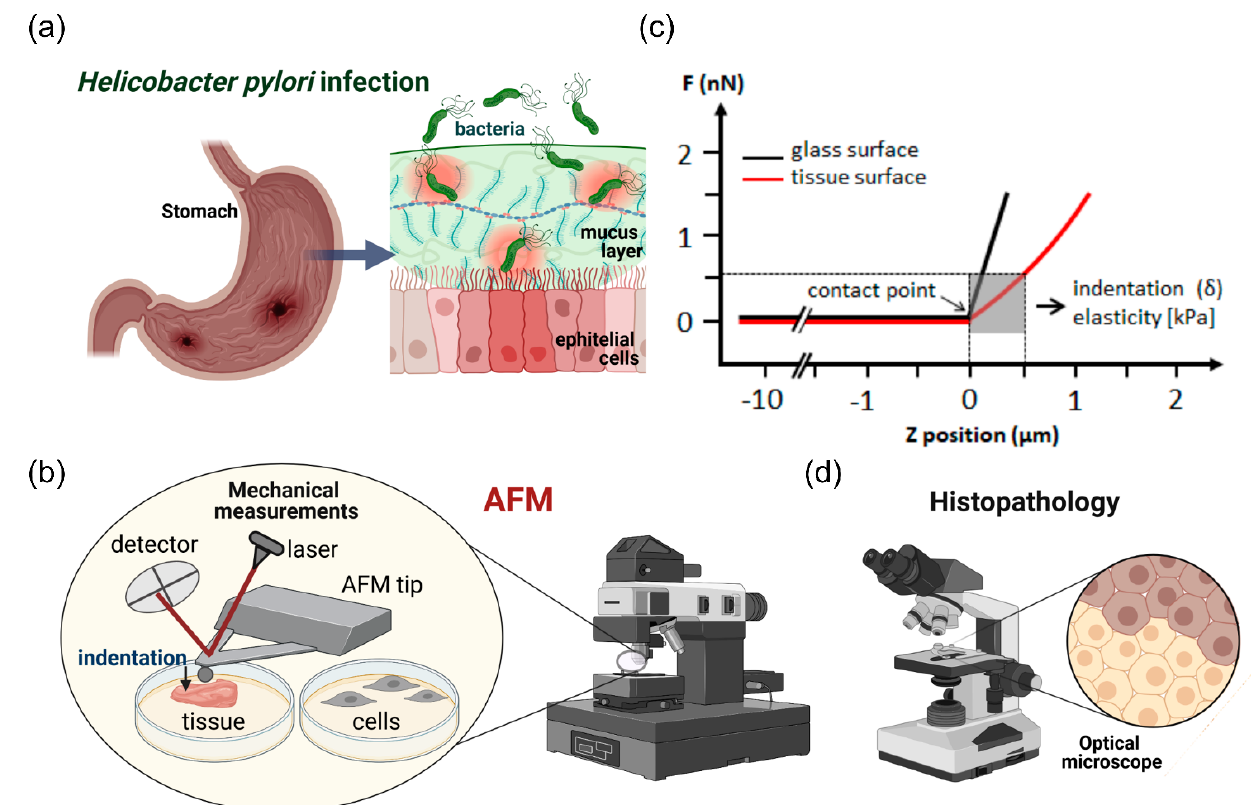
Figure 1. Schematic representation of the experimental setting. Mechanical properties of stomach tissues (Panel a ) were tested using atomic force microscopy (Panel b ) and immunohistochemical staining (Panel d ). Panel c shows a diagram of the method to assess Young’s modulus of tissues and cells. AFM experimental setup/installation: the main AFM components are a cantilever with spherical (a bead with diameter of 4.5 μ m) and pyramidal tip, a laser source, a photosensitive photodiode, and a piezoelectric scanner that can apply a compressive force to soft tissues at the nanoscale. Application of the compressive force measured as a function of a sample’s position in Z-direction induces so called force vs. distance curves (Panel c ). The difference between the cantilever deflection on a stiff glass or hard plastic surface (blue curve) and the soft sample (red curve) describes the deformation of the tissue sample under the load, which permits determination of a sample modulus of elasticity (Young’s modulus).